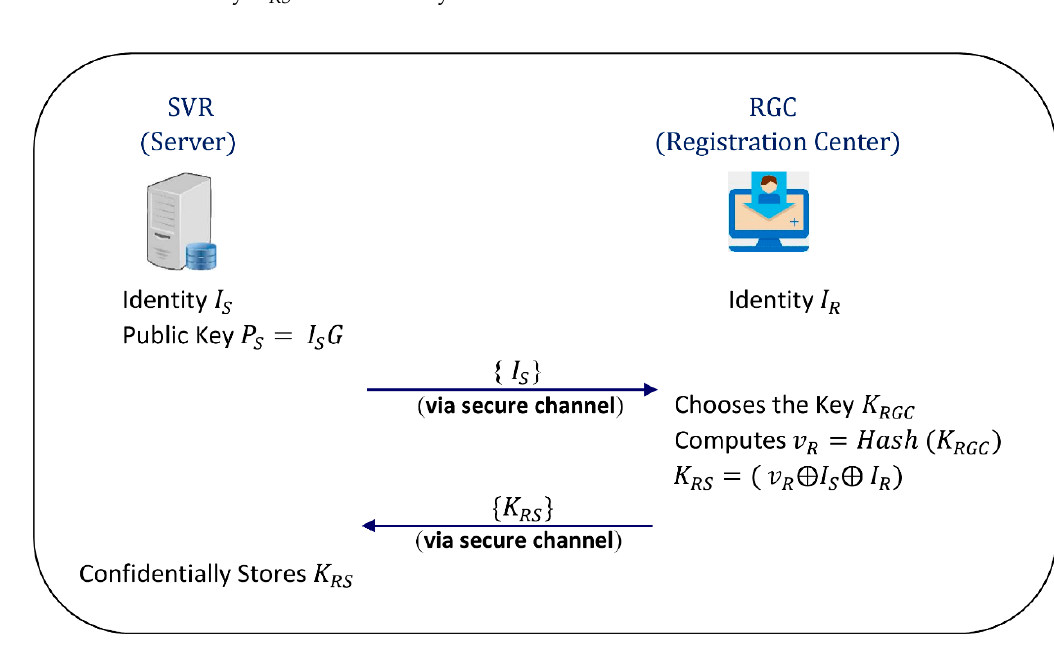
Figure 4. Registration of 𝑆𝑉𝑅 with 𝑅𝐺𝐶 in ECSSP-SC.